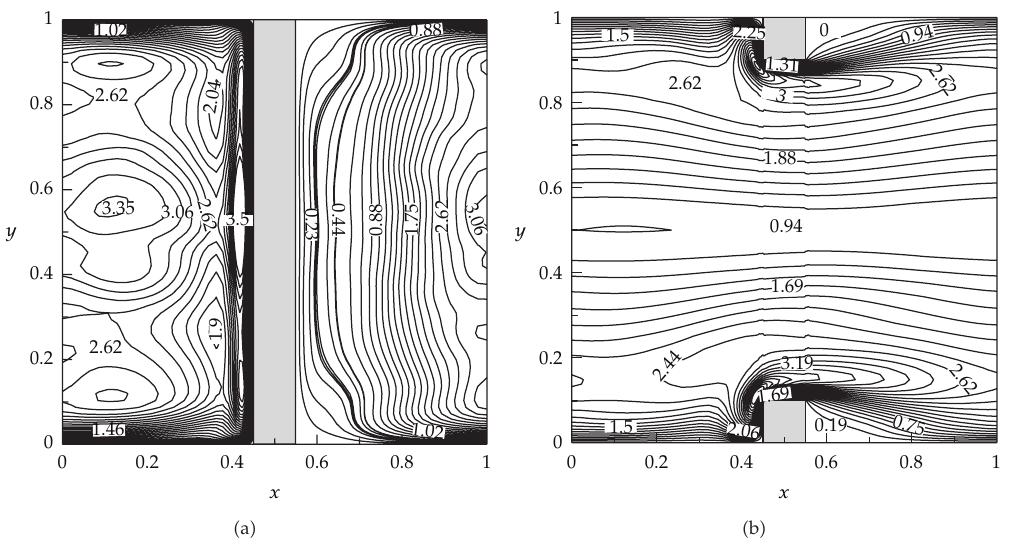
Figure 15: Time-averaged Nusselt number on one of the (cid:2) a (cid:3) ribbed walls (cid:2) b (cid:3) sidewalls.